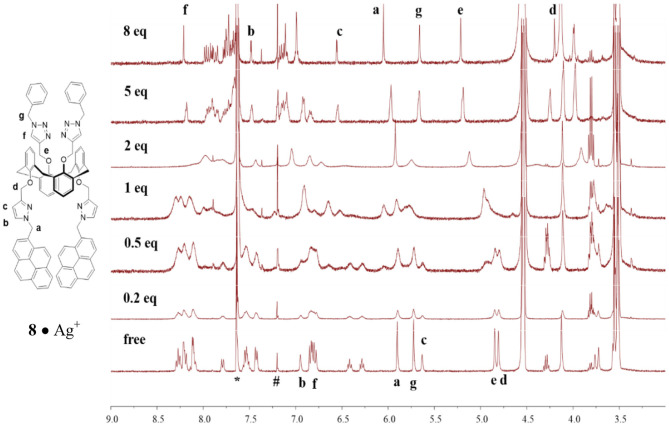
1H NMR titration spectra of ligand 8 (1.33 mM) in the presence of different amount of AgClO4 in CDCl3/CD3OH (v/v, 3:1); where * denotes signals from residual CHCl3 and # denotes signals from external CHCl3.